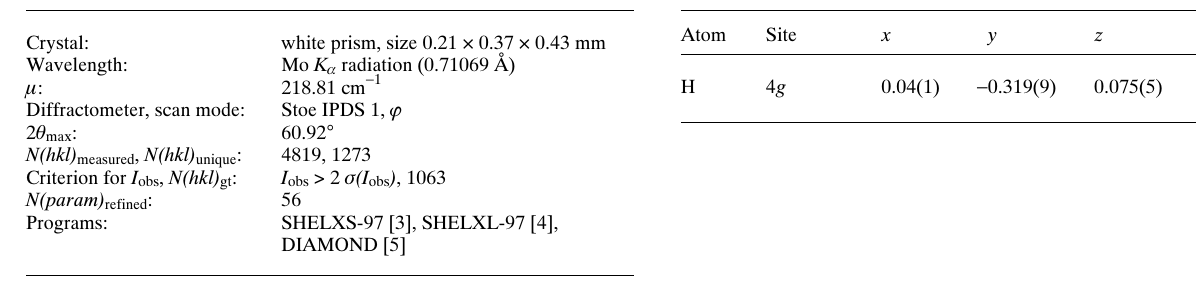
Table 4. Data collection and handling. Table 5. Atomic coordinates and displacement parameters (in Å 2 ) .